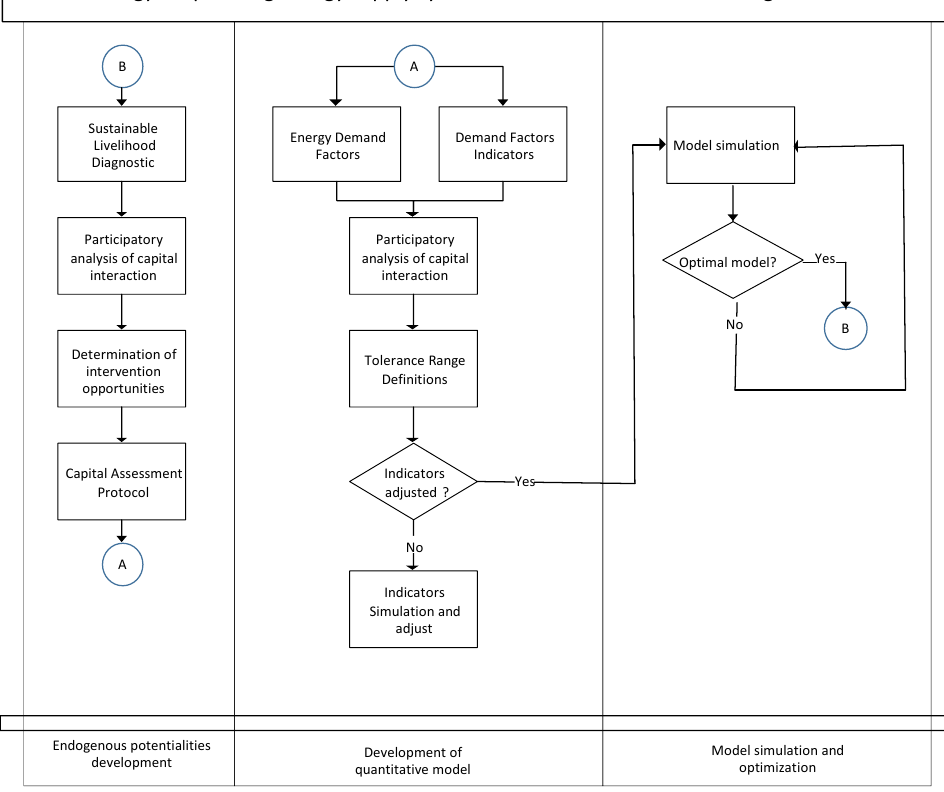
Figure 2. Proposed model for planning energy supply systems in remote communities based on SLs.